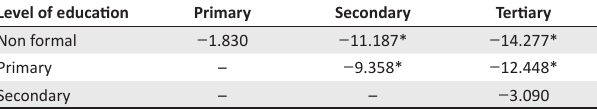
TABLE 2: Results of Scheffe post hoc comparisons across level of education ( n =